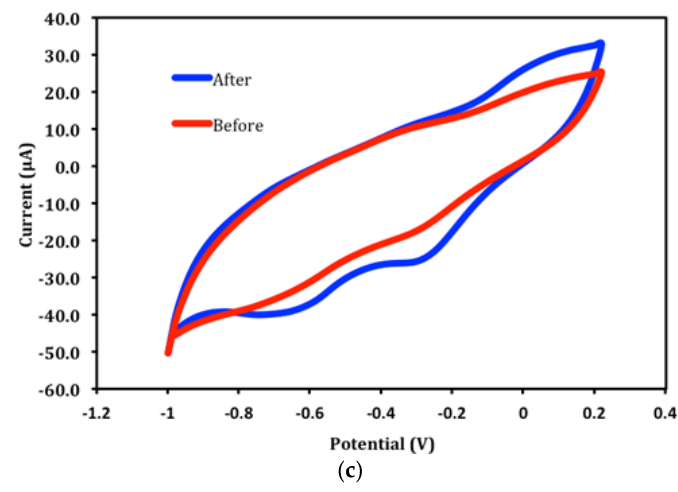
Figure 3. Cyclic voltammograms of bare screen-printed electrode (SPE), poly(nBA)-SPE and poly(nBA)-rGO-SPE in 0.1 M Fe(CN) 63−/4− ( a ); CVs of Hb-SPE, poly(nBA)-rGO-SPE, Hb-rGO-SPE and b-poly(nBA)-rGO-SPE in 0.05 M PBS (pH 7.0) ( b ); CVs of Hb-poly(nBA)-rGO-SPE before and